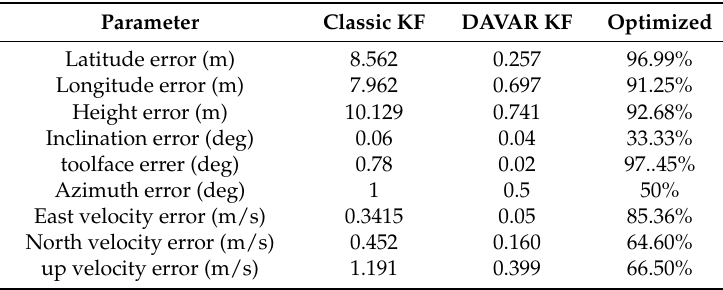
Table 3. The navigation error.